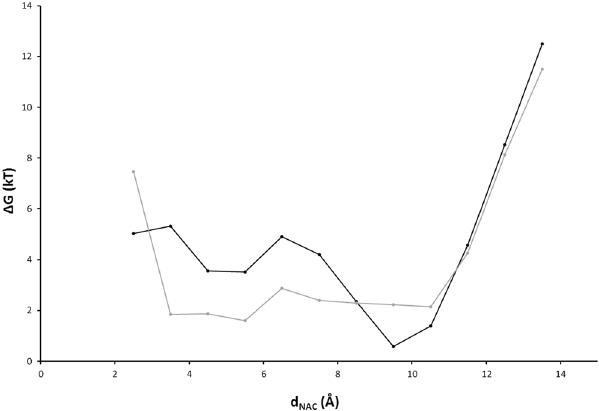
Figure 5. Analysis of conformations of the CPC substrate into the CA binding pocket. Probability calculated from d NAC frequencies were plotted in logarithmic form and expressed in free energies as kT for WT (black) and M6